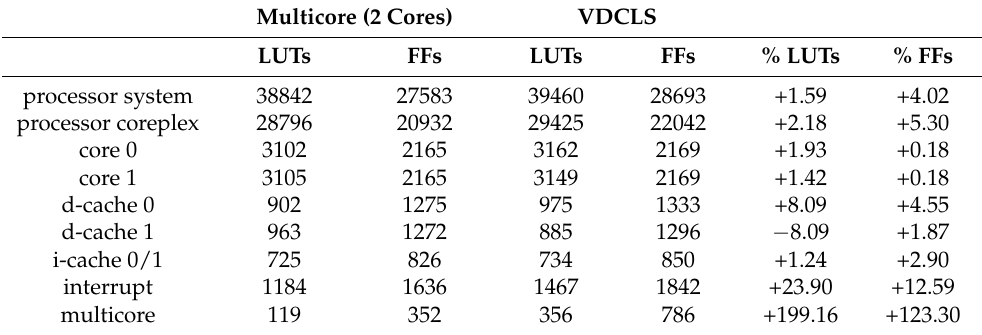
Table 2. Resources utilization comparison between regular dual core and VDCLS implementation using FPGA VCU108